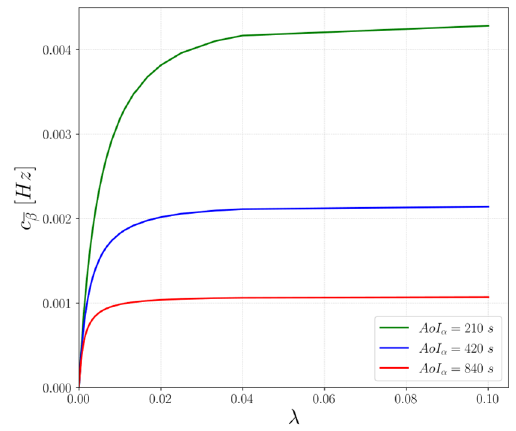
Figure 5. Values of 𝑐 (cid:3081)(cid:3365) for 𝛽̅ = 1 , varying 𝜆 and 𝐴𝑜𝐼 (cid:3080) .